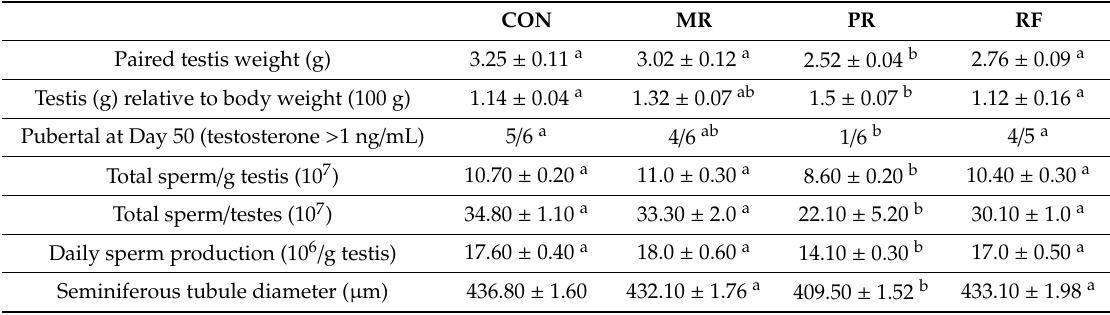
Table 3. Mean (± SEM) effects of feed restriction and refeeding on age at puberty and testicular and sperm end points in rats ( n = 8/group; birth = Day 0).